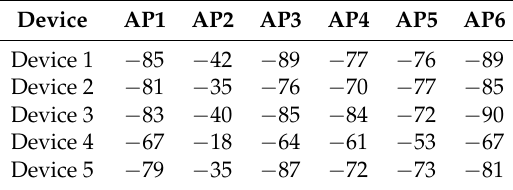
Table 1. Raw crowdsourcing received signal strength (RSS) samples at a particular reference location.